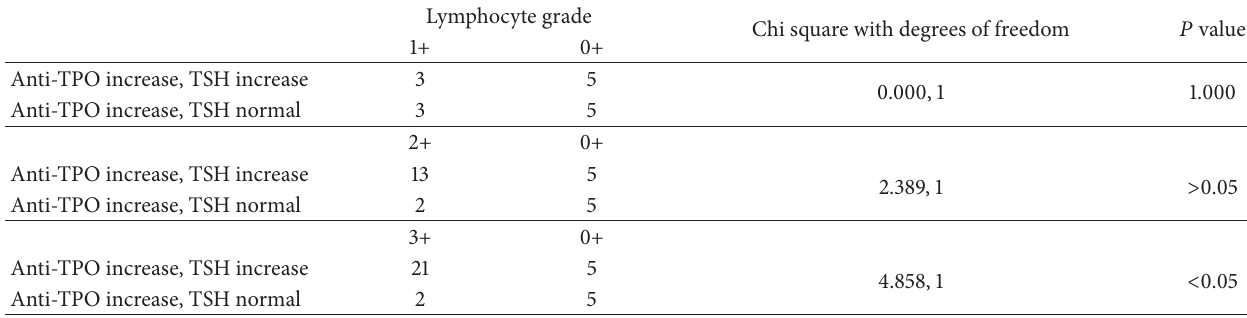
Table 3: Correlation of grading of lymphocytic thyroiditis with anti-TPO and TSH relation. Lymphocyte grade Chi square with degrees of freedom 𝑃 value 1+